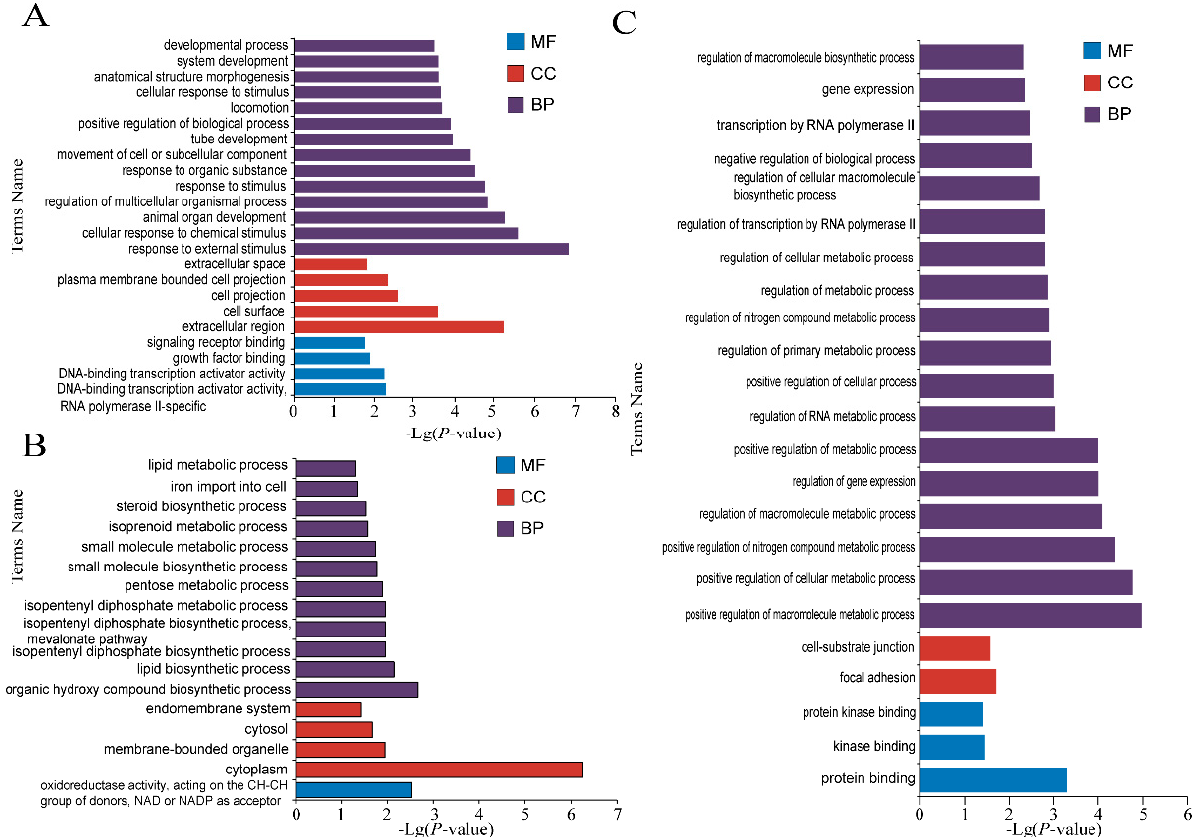
Figure 8. The functional enrichment analysis of specific genes expressed in the pituitary of Small Tail Han Sheep. ( A ) Enriched GO terms of luteal phase, ( B ) Enriched GO terms of estrus. Different bar chart colors represent different items. Purple represents BP, red represents CC, and blue indicated MF.